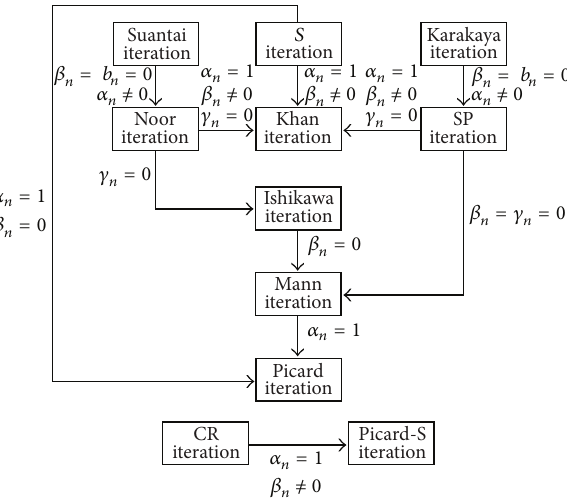
Figure 1: The diagram of iterations’